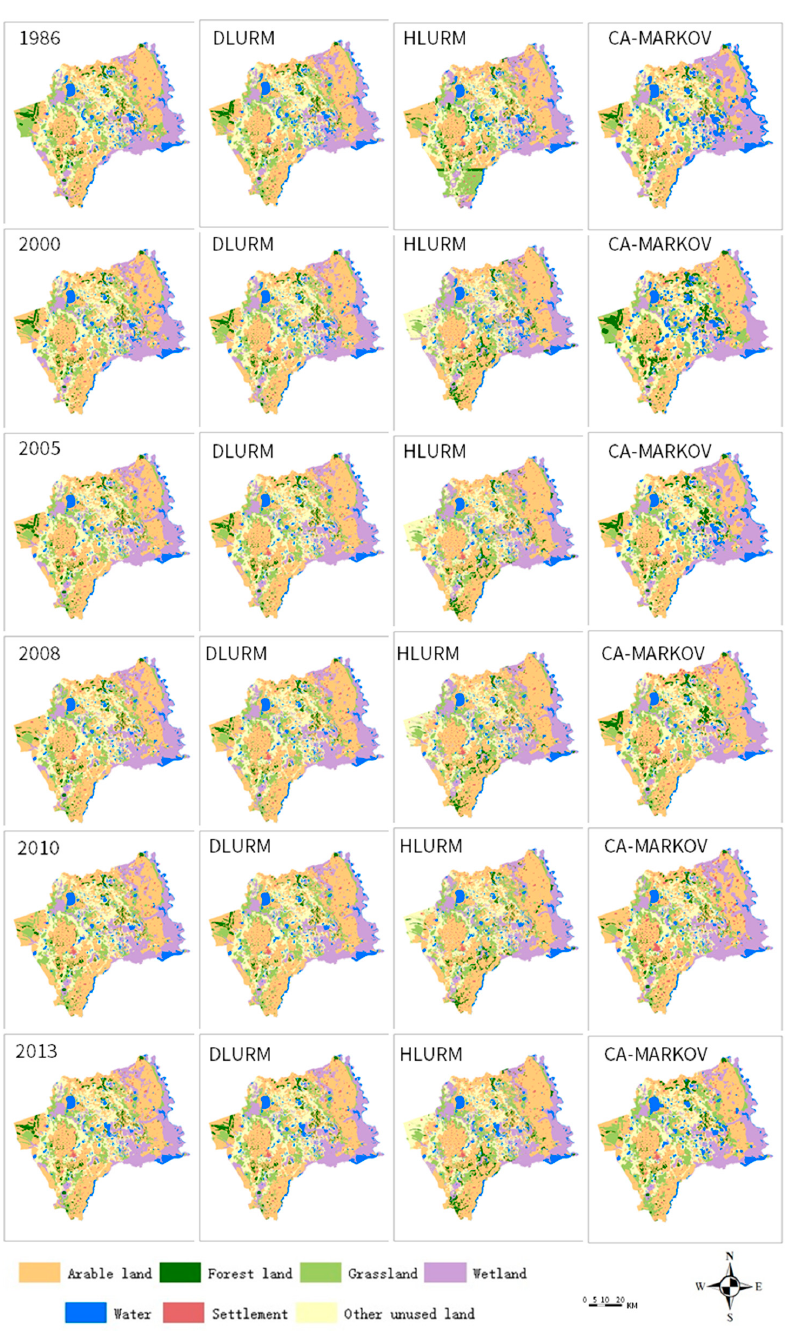
Figure 10. Land use / cover change (LUCC) historical reconstructions through DLURM, historical land use reconstruction model (HLURM), and cellular automata (CA)-Markov